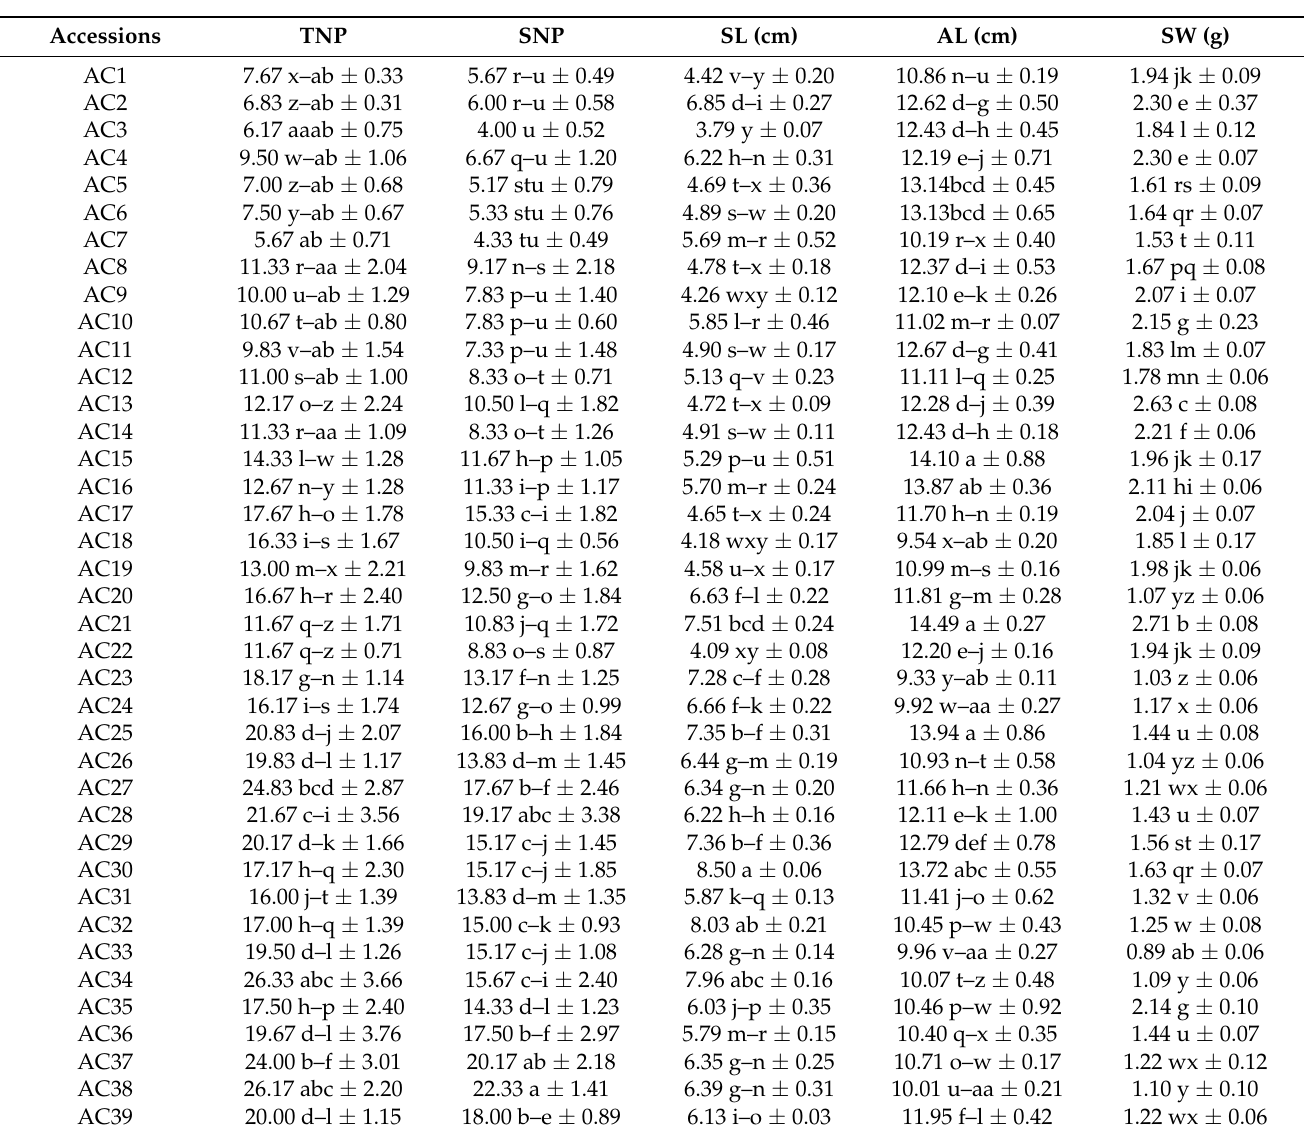
Table 5. Mean pairwise comparison between 59 barley accessions for number of the tillers per plant, number of the spikes per plant, spike length, awan length, and spike weight traits after application of moringa plant